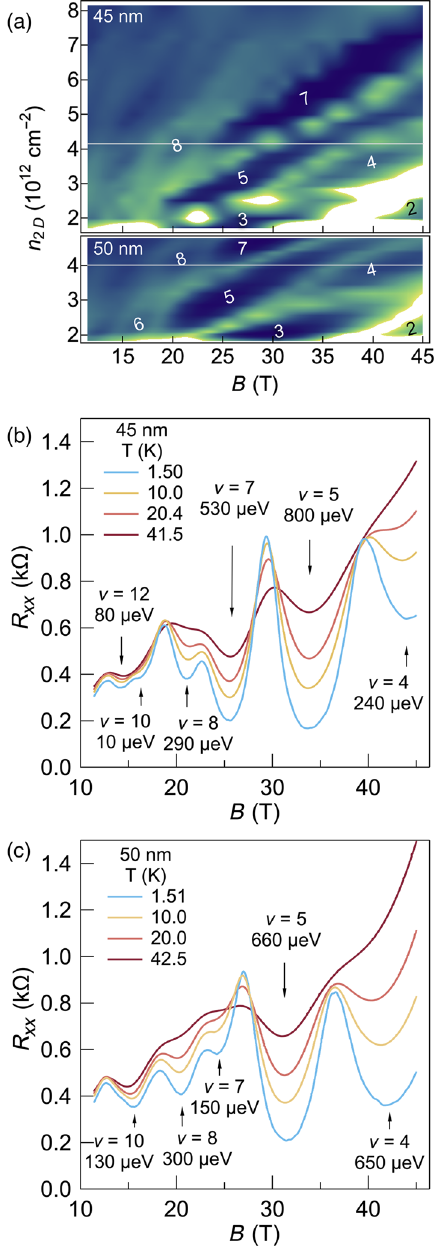
FIG. 2. (a) Maps of the longitudinal magnetoresistance (scaled from dark blue to light green, indicating low to high) for devices made from the 45- to 50-nm films, respectively, as a function of the magnetic field and carrier density. The two panels have the same vertical and horizontalscales.Thinhorizontalgraylines correspond to the carrier density for the traces in (b) and (c). The spotty features are artifacts of the 2D plotting procedure. These are the same data as shown in Figs. 1(c) and 1(d) and Supplemental Figs. S1(a) and S1(b) [28]. (b) Temperature-dependent Shubnikov – de Haas oscil- lations from 1.5 to 42 K for the 45-nm-thick sample. The activation energies shown are calculated from an Arrhenius-type fit to the minima, labeled bythe fillingfactordeduced fromthe indicated R xx . These traces would fall along the thin corresponding value of R xy gray horizontal line on the 2D map in Fig. 2(a). (c) The same as (b) from 1.5 to 43 K for the 50-nm-thick